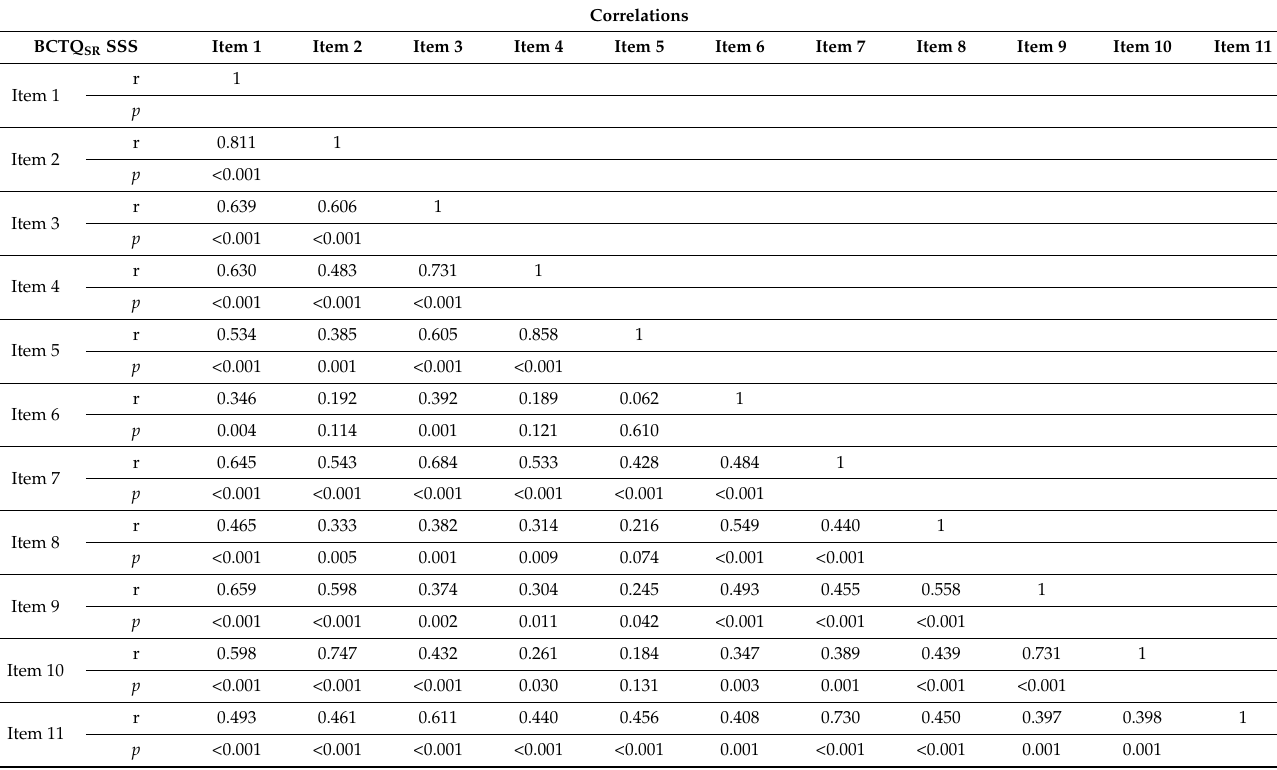
Table 4. Correlations between SSS items on the test. Correlations